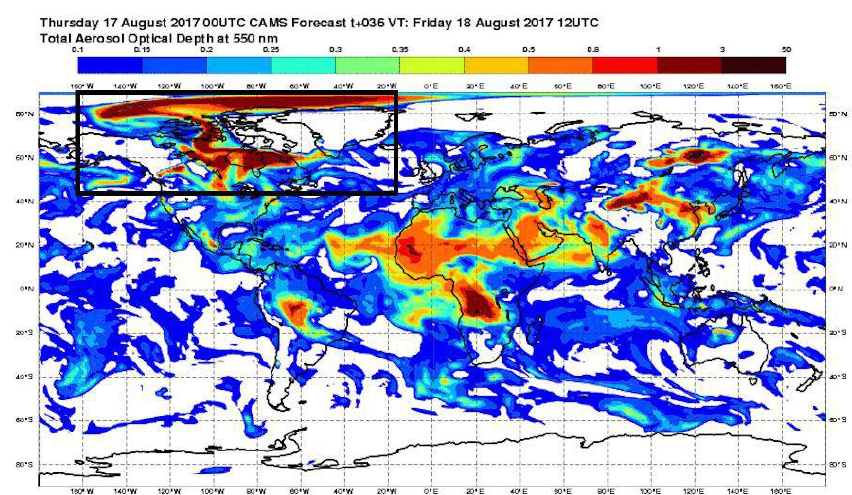
Figure 11. CAMS forecast of Total Aerosol Optical Depth at 550 nm for 18 August 2017.